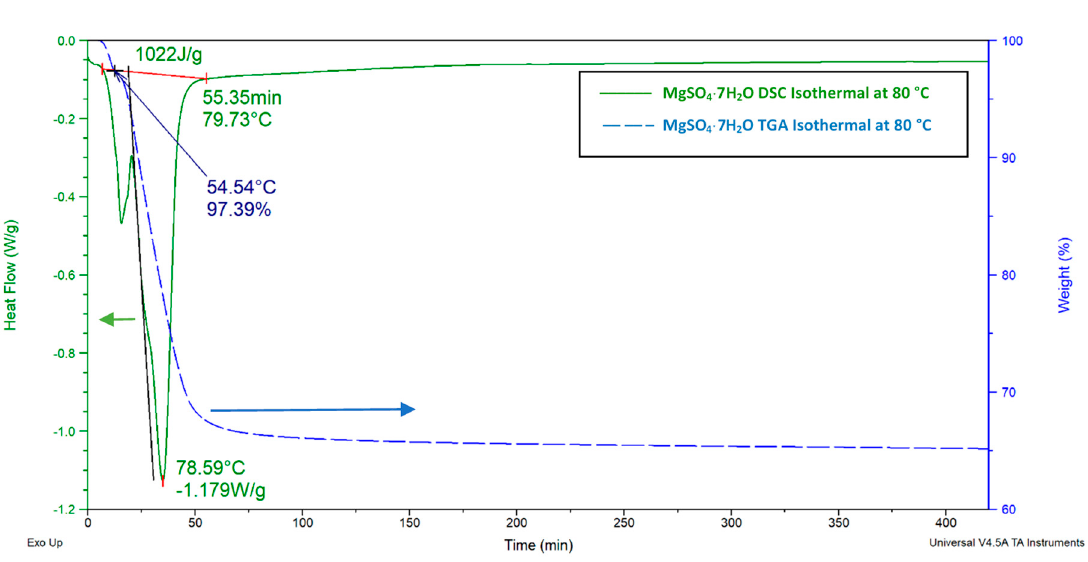
Figure 15. MgSO 4 · 7H 2 O isothermal TGA and DSC charts. For DSC, 3 ◦ C · min − 1 heating and 20 Figure 15. MgSO 4 ⋅ 7H 2 O isothermal TGA and DSC charts. For DSC, 3 °C ⋅ min − 1 heating and 20 ml ⋅ min − 1 ml · min − 1 N 2 flow heating rates were used, and the sample was held isothermal at 80 ◦ C for 420 min. N 2 flow heating rates were used, and the sample was held isothermal at 80 °C for 420 minutes. For the For the TGA test, the sample was heated at a 3 ◦ C · min − 1 heating rate from room temperature and was TGA test, the sample was heated at a 3 °C ⋅ min − 1 heating rate from room temperature and was held held isothermal at 80 ◦ C for 420 isothermal at 80 °C for 420 minutes.